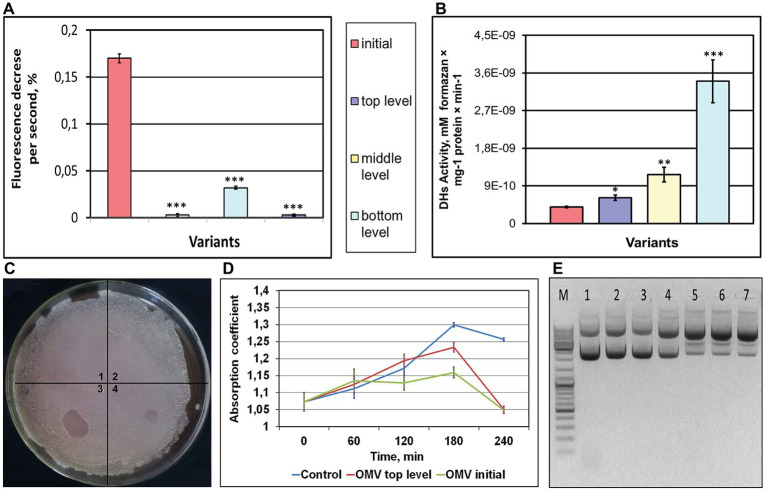
Functionality of OMVs of K. intermedius, isolated from post-flight KMCs (A,B,D,E) and extracellular vesicles (EVs) isolated from the post-flight KMC samples (C). (A) OMVs acidification measured using a pH-sensitive fluorescent dye acridine orange. Typical recording of acidification of OMVs from K. intermedius isolated from initial KMC and KMCs located at the top, middle, and bottom levels of a carrier mounted outside the ISS. (B) Dehydrogenase activity of OMVs of K. intermedius re-isolated from different KMCs. Data were shown as mean ± SD (n = 3), *p ≤ 0.05; **p ≤ 0.01; ***p ≤ 0.001. (C) The image of Bacillus subtilis lawn spotted with EVs. Clear zones are seen in spots of EVs from initial KMC (4) and EVs from bottom-located KMC (2). No visible changes seen after spotting with EVs of top‐ (1) and middle-located KMC (3). (D) Inhibitory activity of OMVs from K. intermedius in regard to B. subtilis. (E) Electrophoregram of plasmid pTZ19R after incubation with OMVs of K. intermedius. M–DNA ladder (ThermoFisher Scientific GeneRuler DNA Ladder Mix). 1 – control DNA (without incubation); 2 – control DNA (incubation, 37°С); 3 – control DNA (+PBS, incubation, 37°С); 4 – OMVs of K. intermedius from initial KMC; 5–7 – OMVs of K. intermedius from bottom-, middle-, and top-located KMCs, incubated with DNA at 37°С.